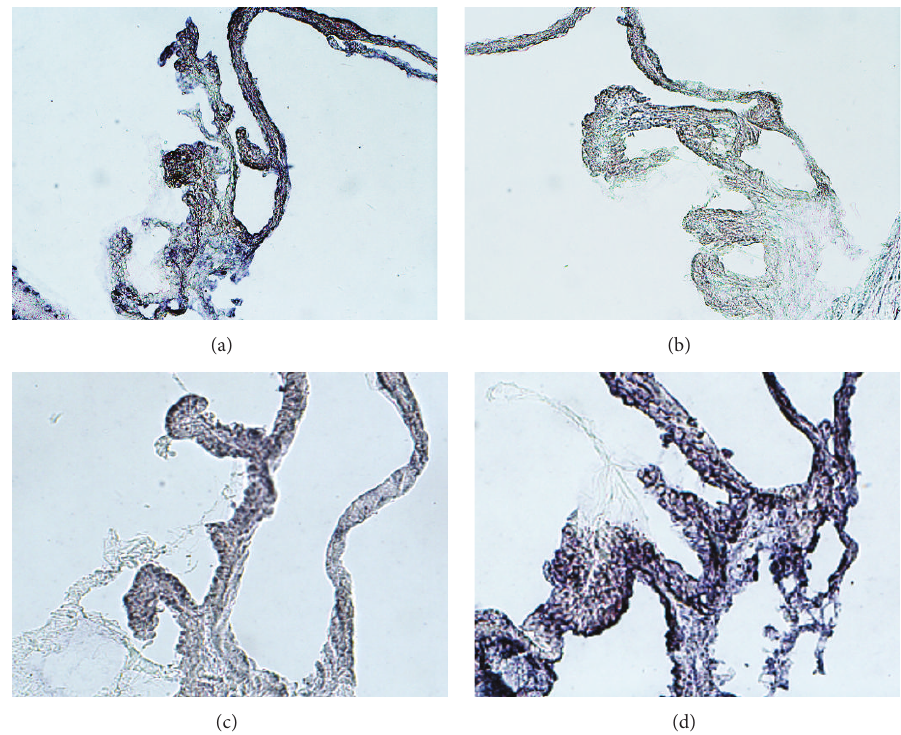
Figure 4: In situ hybridization of microRNAs in iris/ciliary body tissue. (a) + (b) miR-146-5p at day 15 after immunization: note the decreased purpledots,whichreflectthelowerexpressioninthestudyeye(b)thaninthecontroleye(a).(c)+(d)miR-182-5patday10afterimmunization: note the increased purple dots, which reflect the higher expression in the study eye (d) than in the control eye (c).